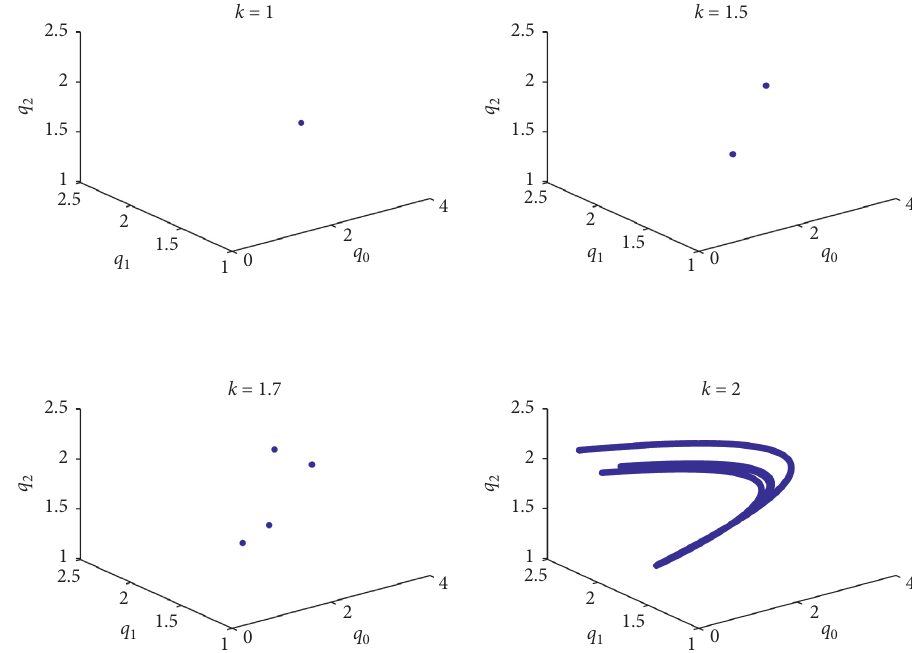
Figure 3: Phase portraits for Figure 2 with various values of k